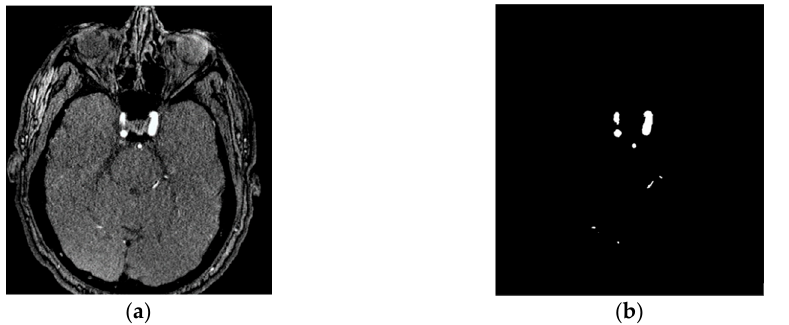
Figure 2. ( a ) Original MRA image slice of sample patient at day 0. ( b ) Manually segmented ground truth (GT) image from image in ( a ).